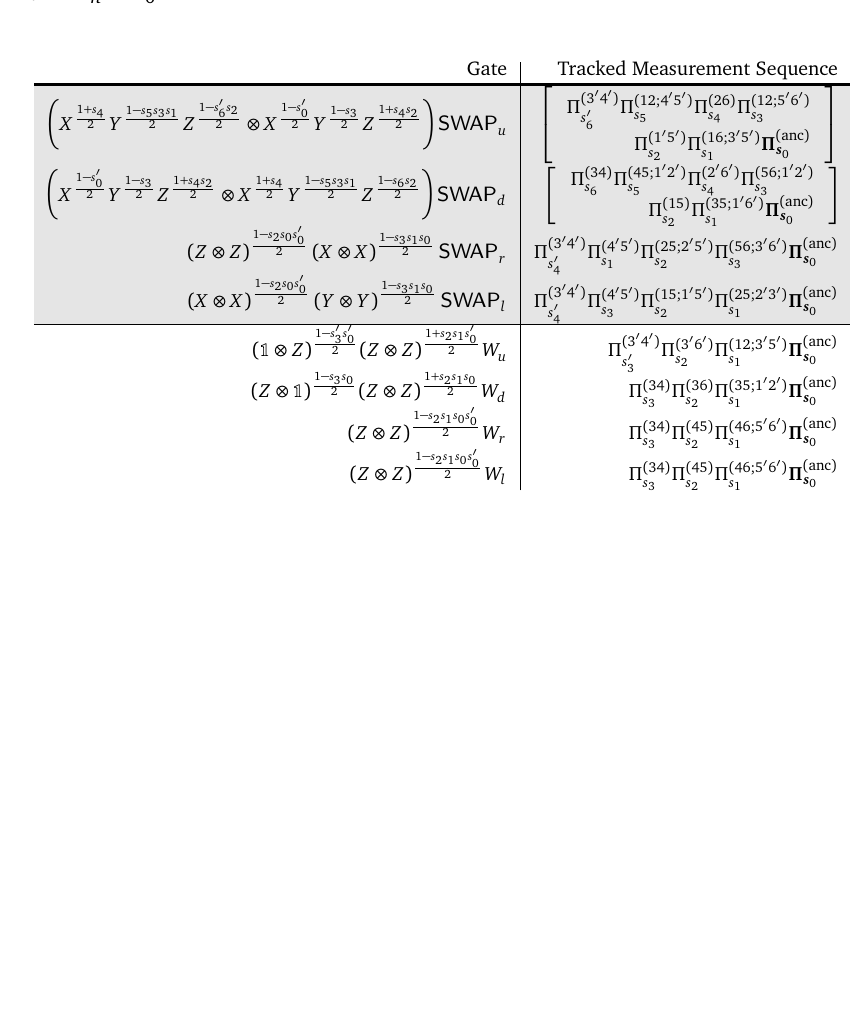
Table 20: Pauli gate corrections tracked for the corresponding SWAP and W gates implemented using Majorana-Pauli tracking methods. The implicit action on the for sequences of length n . (When s (cid:48) 0 there is not a final projector for one of the ancillary pairs, it is equivalent to there being a projector for that ancillary pair onto its initial projection channel,